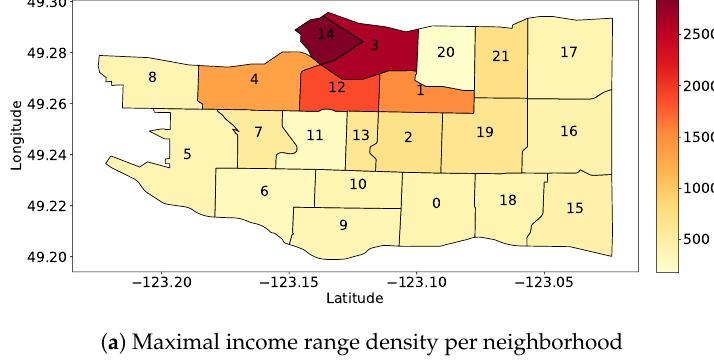
Figure 5. Time series of weather conditions per hour during September 2017. Each point in the plot represents an occurred weather type.